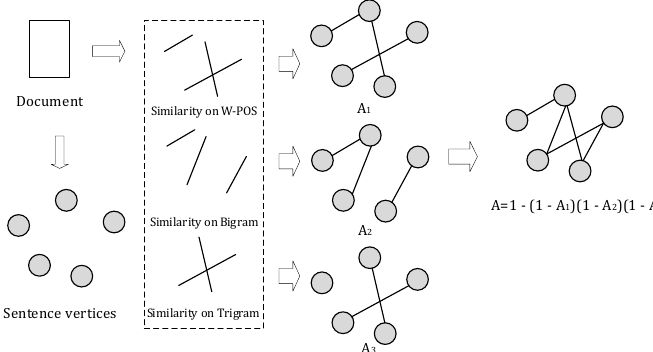
Figure 2. Graph integration using the naive Bayesian fashion.